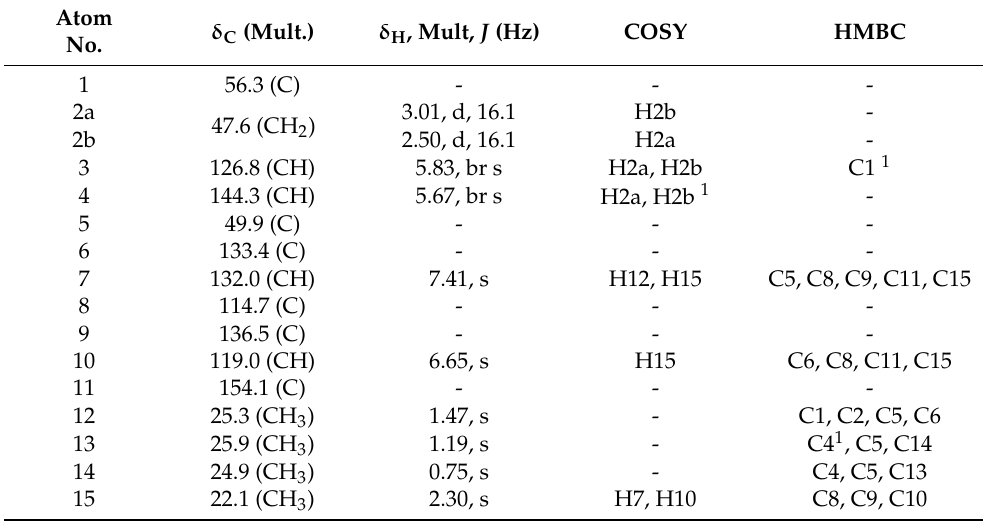
Table 1. NMR spectroscopic data for compound 4